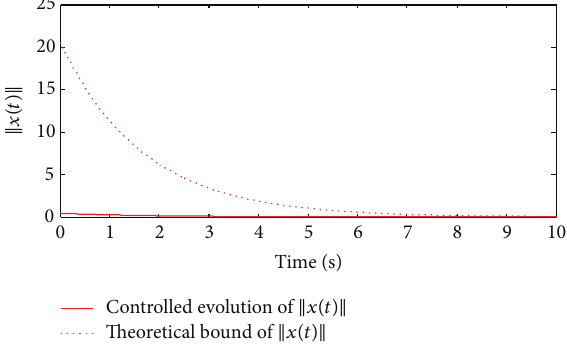
Figure 2: The evolution of ‖𝑥(𝑡)‖ with linear state feedback control = −40𝑥 𝑢 2 2 . Also shown is theoretical bound of